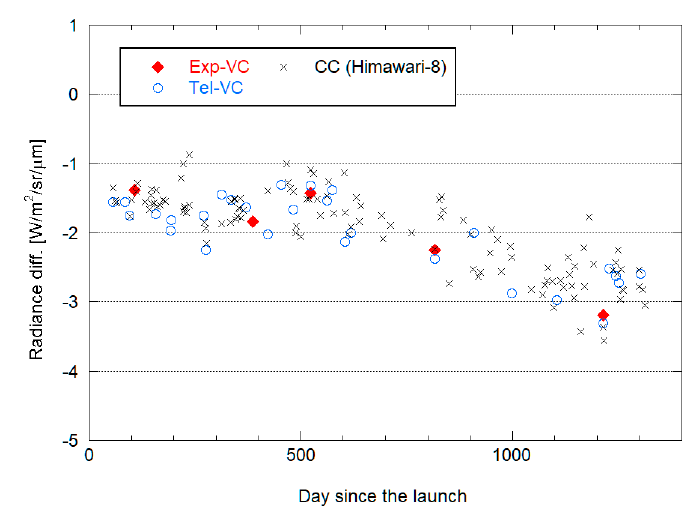
Figure 18. Difference between the ground testing-based radiance ( R 1 ) and the predicted radiance for CALET/CIRC as a function of the day since the launch ( D ).